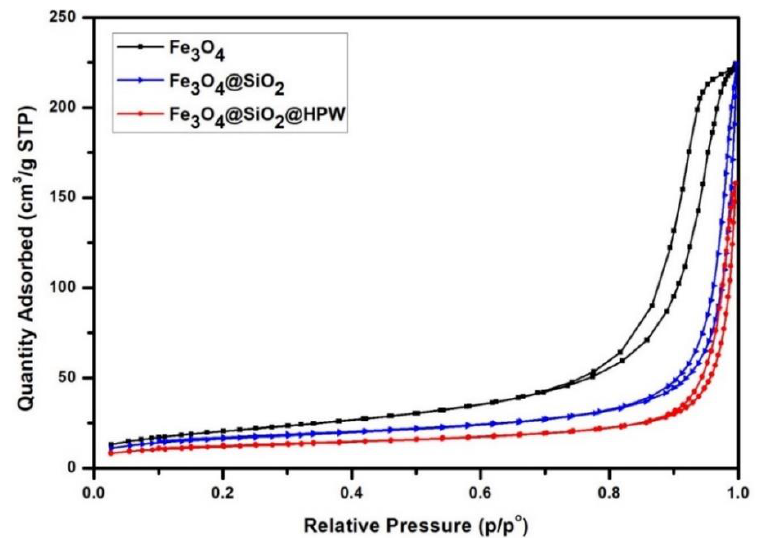
Figure 8. N2 adsorption-desorption isotherms of Fe 3 O 4 , Fe 3 O 4 @SiO 2 , and Fe 3 O 4 @ SiO 2 @HPW .